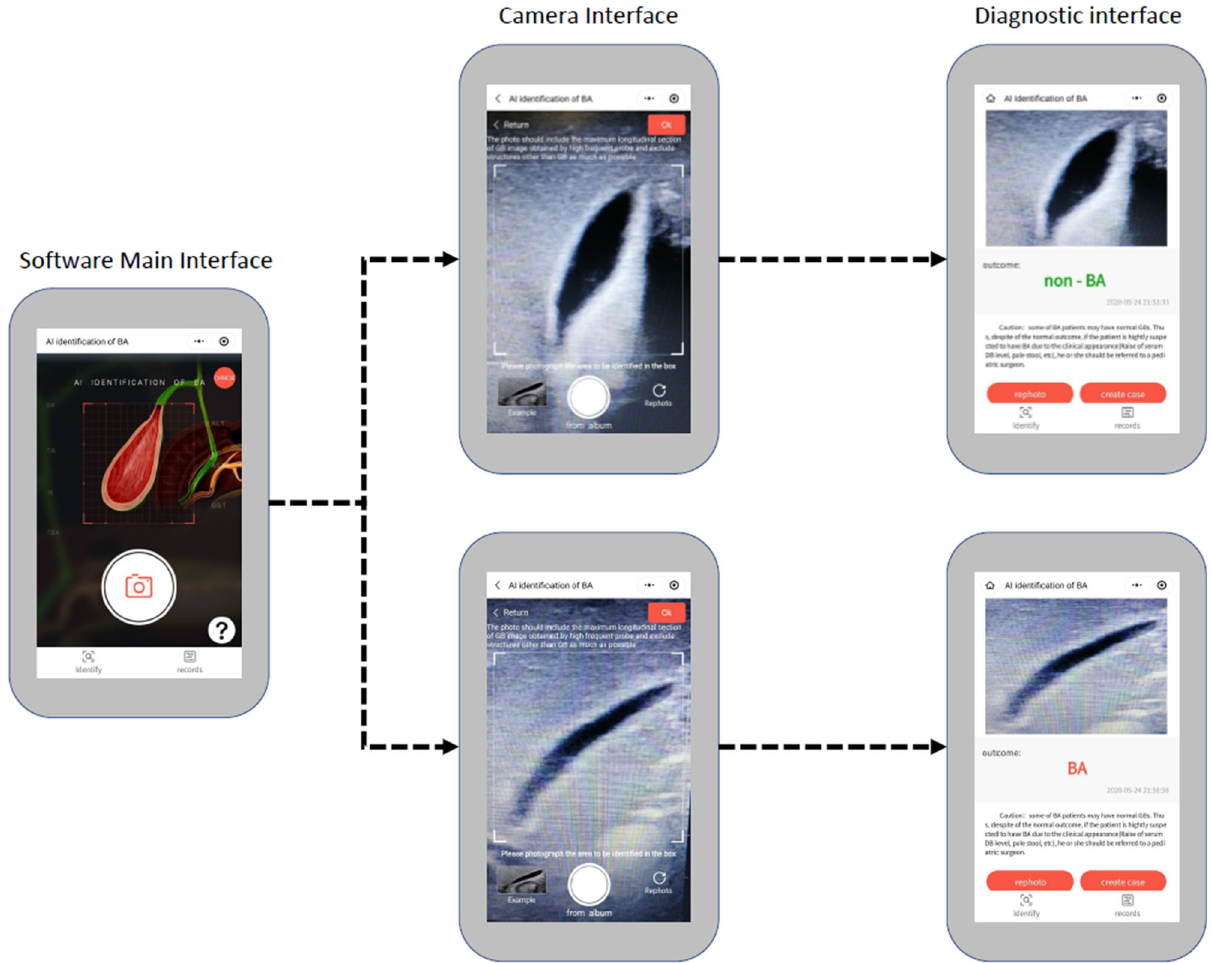
Fig. 4 The user interface for each step of the smartphone app. Firstly, the users open the app and take a photo of gallbladder from the screen of a sonographic machine. The photo should include the maximum longitudinal section of gallbladder image obtained by high frequent probe and exclude structures other than gallbladder as much as possible. The users then press “ Ok ” to send the photo to a cloud platform. The outcome of BA or non-BA will show on the smartphone screen in a few seconds. BA biliary